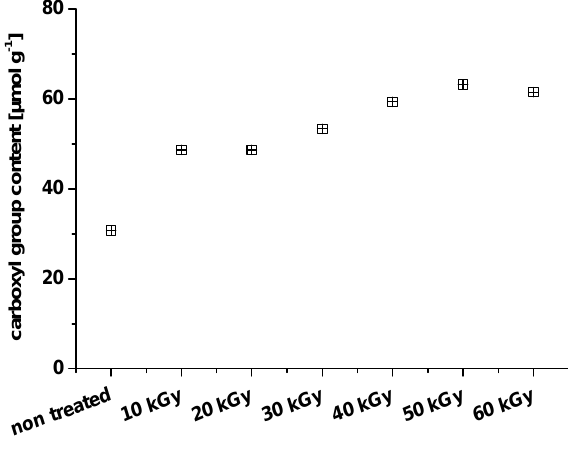
Figure 10. Development of the carboxyl group content in MFC after irradiation with increasing